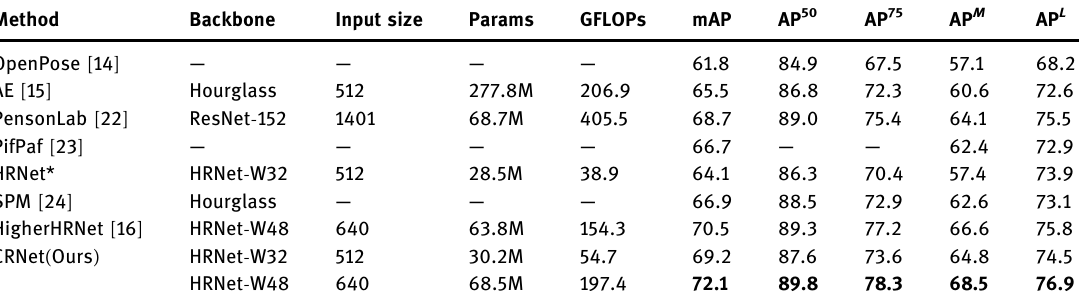
Table 1: Comparisons with state - of - the - arts on the COCO test - dev set Method Backbone